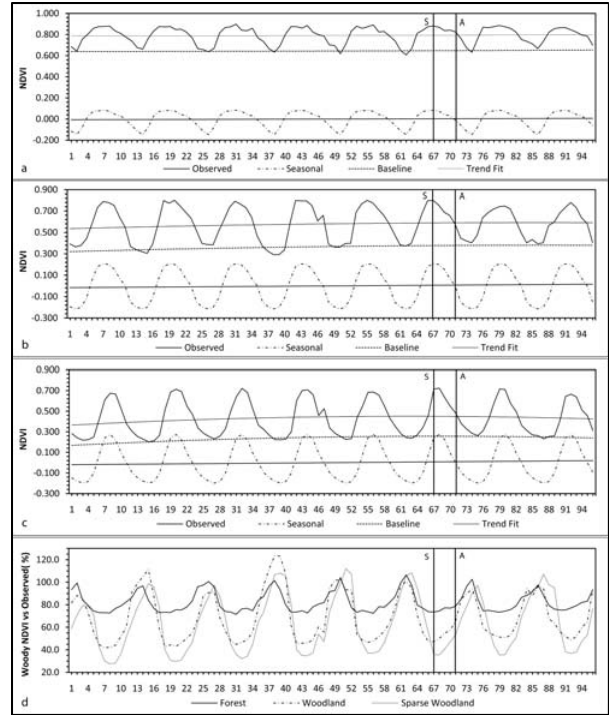
Figure 4. Seasonal components, trend and baseline of NDVI series and the percentage of the woody component a: forest, b: woodland, and c: sparse woodland; d: woody NDVI versus observed NDVI ( R ); S: summer and N: autumn (Nov.) of 2007 (Note: numbers on horizontal axis represent monthly time steps, with 1: Jan. 2002 and 96: Dec.